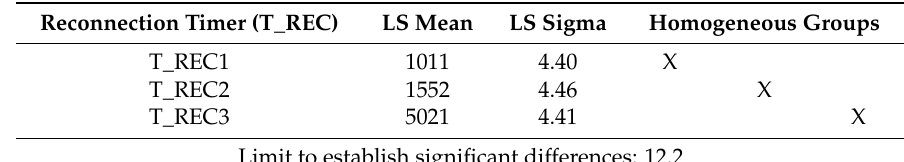
Table 10. Results of the Multiple Range Tests for the factor Reconnection Timer (T_REC) using as dependent variable Convergence Time.